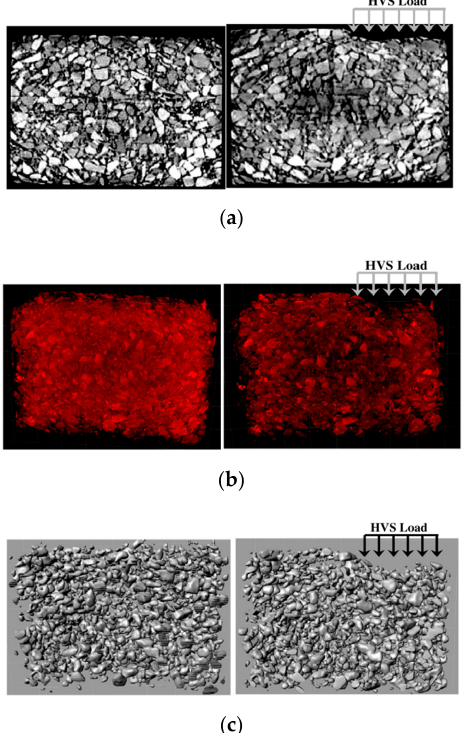
Figure 14. The procedure followed for aggregate domain creation: ( a ) unprocessed 2D X-ray CT image used for the development of image stacks (left: before HVS trafficking and right: after HVS trafficking), ( b ) 3D images developed from X-ray CT image stacks (left: before HVS trafficking and right: after HVS trafficking), and ( c ) 3D aggregate volumes (left: before HVS trafficking and right: after HVS trafficking). Note: direction of HVS traffic is out of the page. Reprinted with permission from [ 88 ] . 2012, Construction and Building Materials, Elsevier.